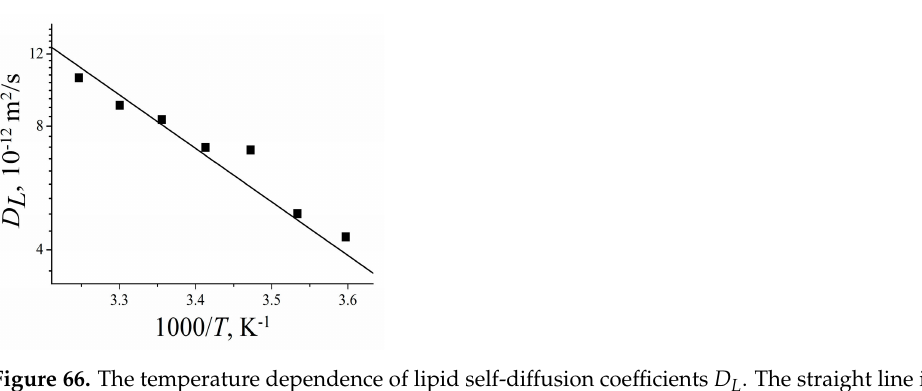
Figure 66. The temperature dependence of lipid self-diffusion coefficients D L . The straight line is the Arrhenius equation approximation. The activation energy is 25 ± 2.9 kJ/mol. The diffusion time t d is 10 ms. Reprinted with permission from [171]. Copyright 2016 Springer Nature.